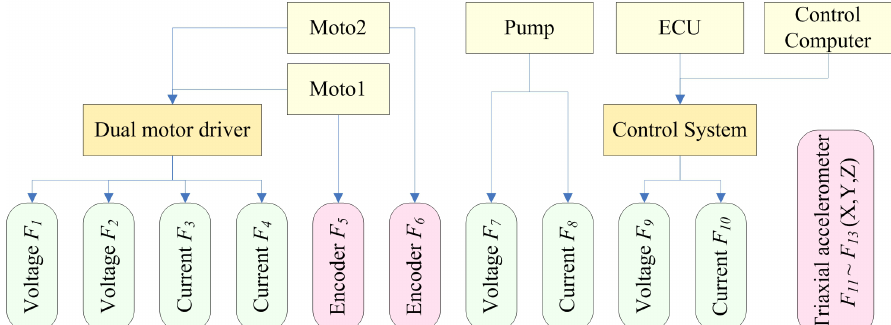
Figure 12. Multi-channel sensor signal